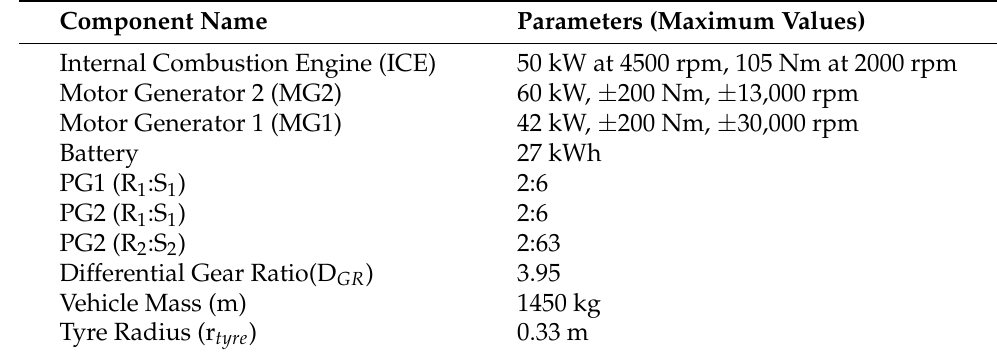
Table 1. Sizes of the powertrain components.